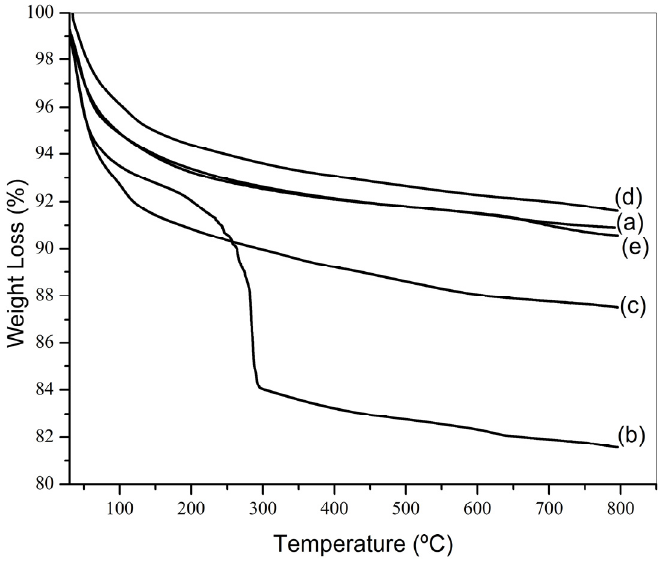
O (non-calcined); ( c ) MnAlT400; ( d ) MnAlT400W y; ( e ) MnAlW600. 2 3